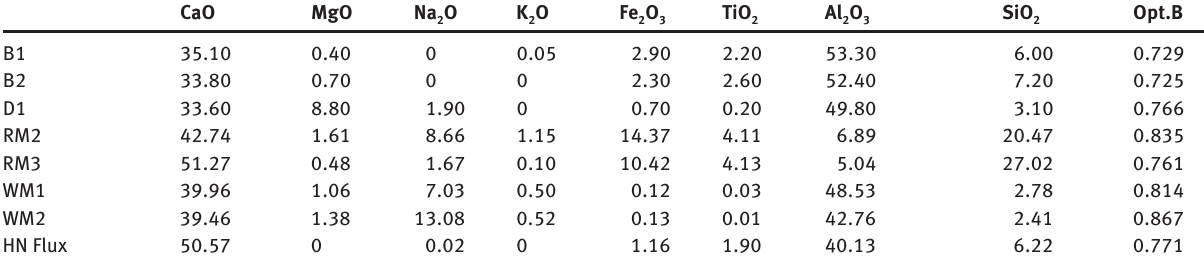
Table 2: Compositions of Calcium Aluminate Fluxes made from Different Sources